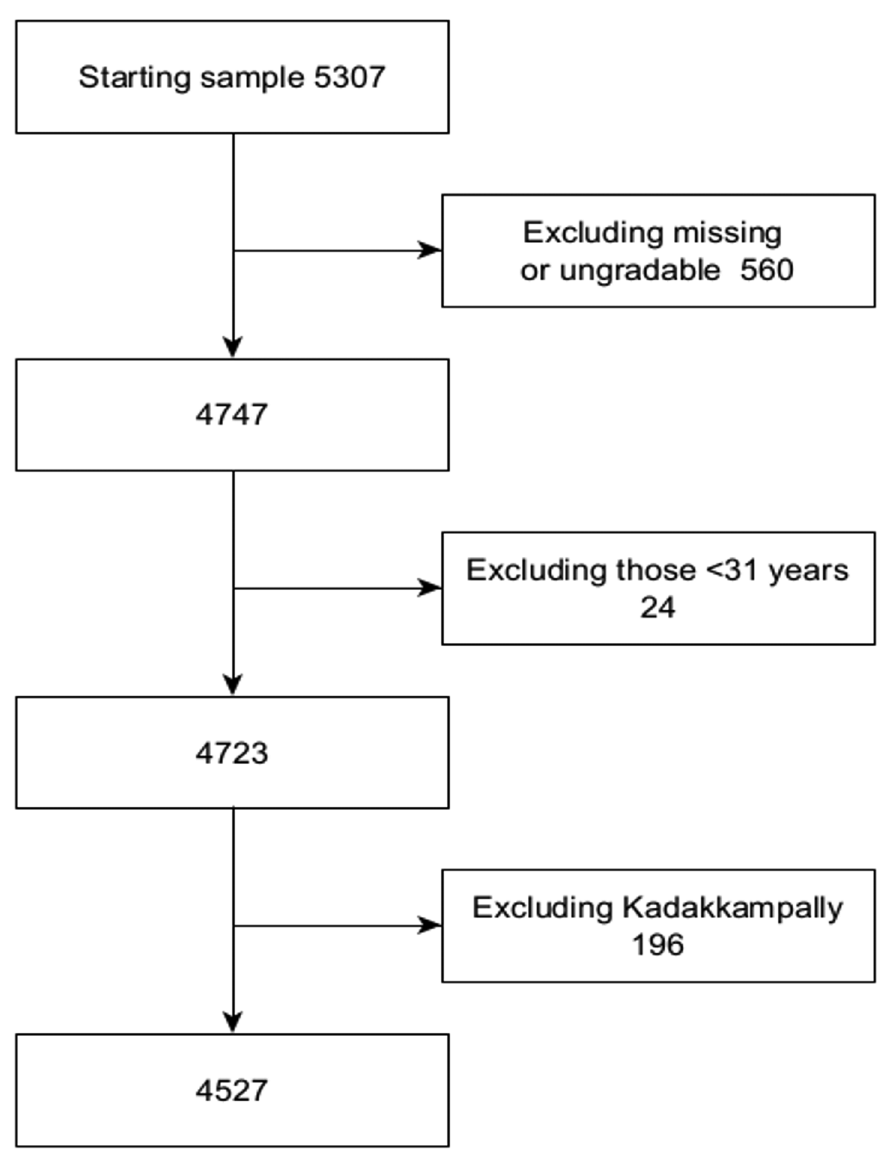
Figure 1. Flow diagram showing derivation of the study sample size. Table 1. The representativeness of the sample at each FHC.